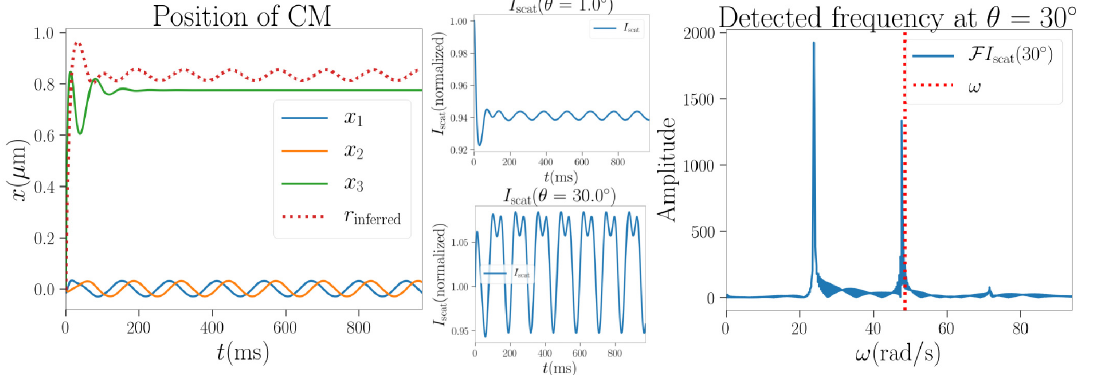
Fig 18. Left: Simulated position of the particle and simulated measurement of the distance from origin (dotted line). Middle: Simulated measurements of scattered intensity. Right: Simulated measurement of the angular frequency and true simulated final value (dashed line), where scattering fluctuations due to precession are the cause of the leftmost peak with lower